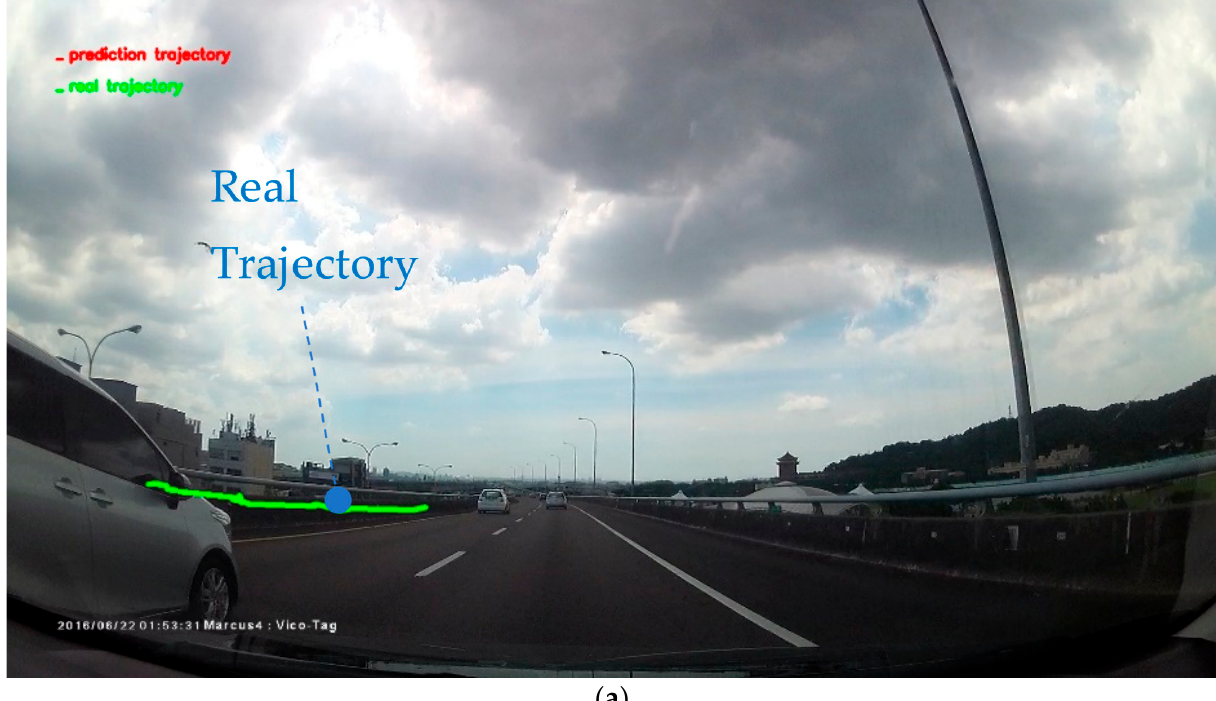
Figure 22. The training of the car trajectory prediction model. We showed the results in four rows: ( a ) the accuracy of predicting x coordinates model, ( b ) the loss of predicting x coordinates model, ( c ) the accuracy of predicting y coordinates model, ( d ) the loss of predicting y coordinates model; ( e , f ) compare the real x coordinates and predicted x coordinates. The blue line is x coordinates predicted by our model, and the orange line is the real x coordinates; ( g , h ) compare the real y coordinates and predicted y coordinates. The blue line is y coordinates predicted by our model, and the orange line is the real y coordinates. Table 11. The training results of car trajectory prediction model.